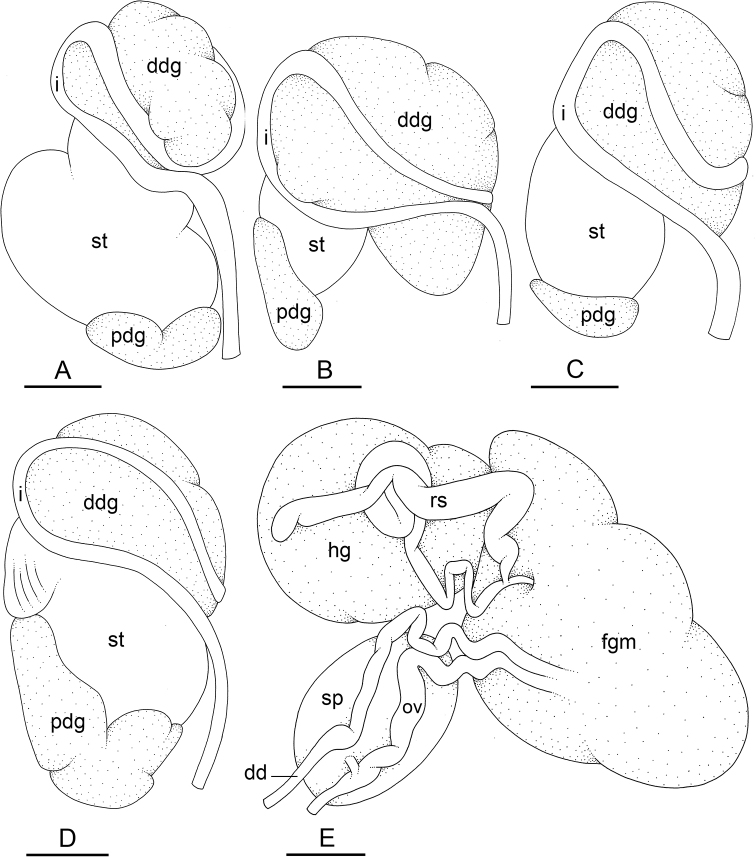
Peronia
madagascariensisA–D digestive system, dorsal view, with intestinal loops of type V E posterior, hermaphroditic (female) reproductive system A holotype, Paraperonia
madagascariensis, Madagascar (MNHN-IM-2000-33680) B paralectotype, Paraperonia
gondwanae, Mumbai, western India (MNHN-IM-2000-33682) C paralectotype, Paraperonia
gondwanae, Red Sea (MNHN-IM-2000-33683) D Madagascar, [5501] (MNHN-IM-2009-16392) E same as D. Scale bars: 5 mm (A–D), 2 mm (E). Abbreviations: dd deferent duct, ddg dorsal digestive gland, fgm female gland mass, hg hermaphroditic gland, i intestine, ov oviduct, pdg posterior digestive gland, rs receptaculum seminis, sp spermatheca, st stomach.